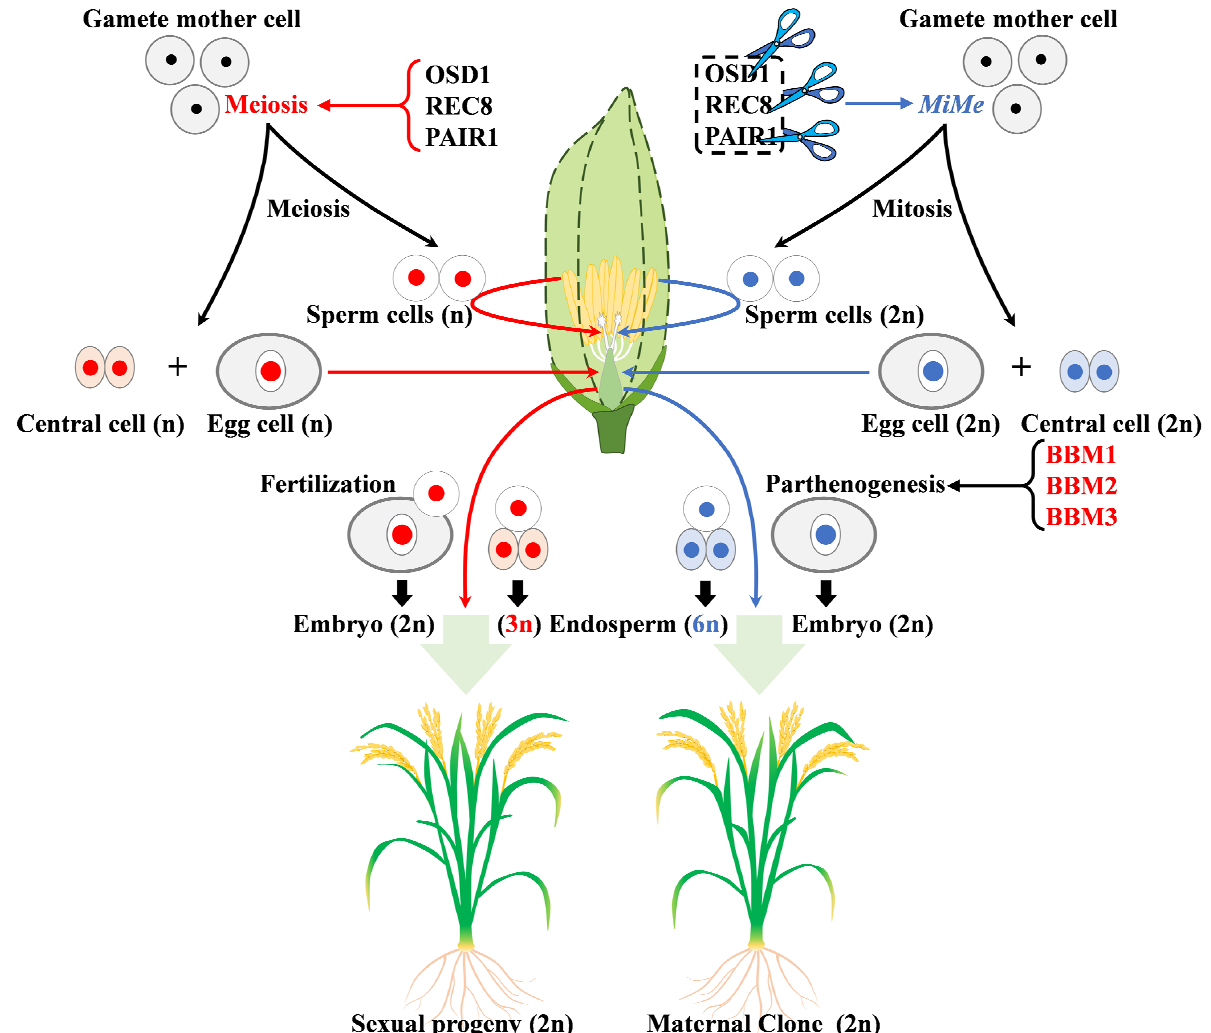
Figure 3. Schematic representation of sexual reproduction and synthetic apomixis regulated by MiMe and BBMs in rice. The genes in this figure are described in Section 3.4. Left is the sexual reproduction process in which the germ cells form haploid gametes through processes such as meiosis and double fertilization that produce a diploid (2n) embryo and a triploid (3n) endosperm. Apomixis on the right consists of two main modifications: one is the knockdown of OSD1 , REC8 and PAIR1 , which converts meiosis into mitosis (a technique called MiMe ), resulting in 2n egg, sperm cells and central cells. The second is parthenogenesis induced by BBMs (AP2/ERF transcription factors), which converts (2n) egg cells into embryos and produces (6n) endosperm. Table 5. Genes associated with embryogenesis in rice.